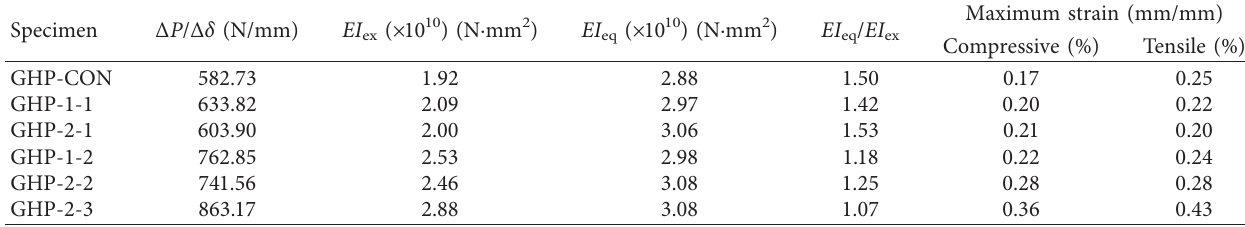
Table 3: Summary of stiffness and strain of GHP specimens.